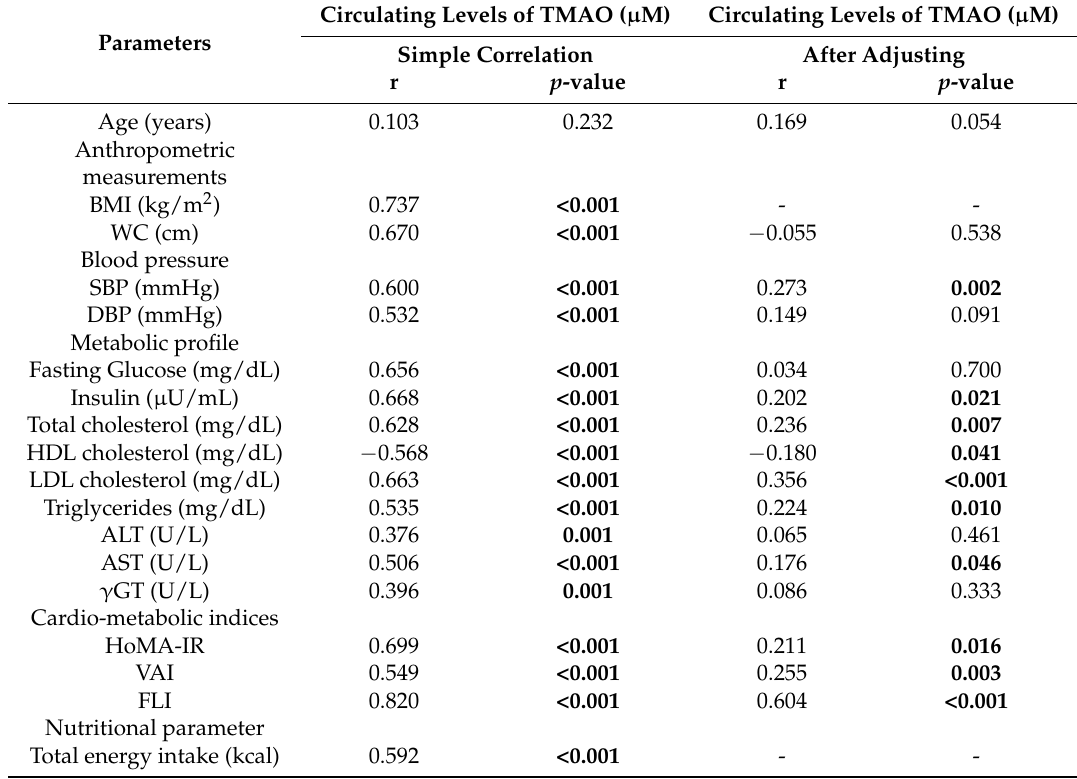
Table 3. Correlations among circulating levels of TMAO with age, anthropometric characteristics, blood pressure, metabolic profile, cardio-metabolic indices, and nutritional